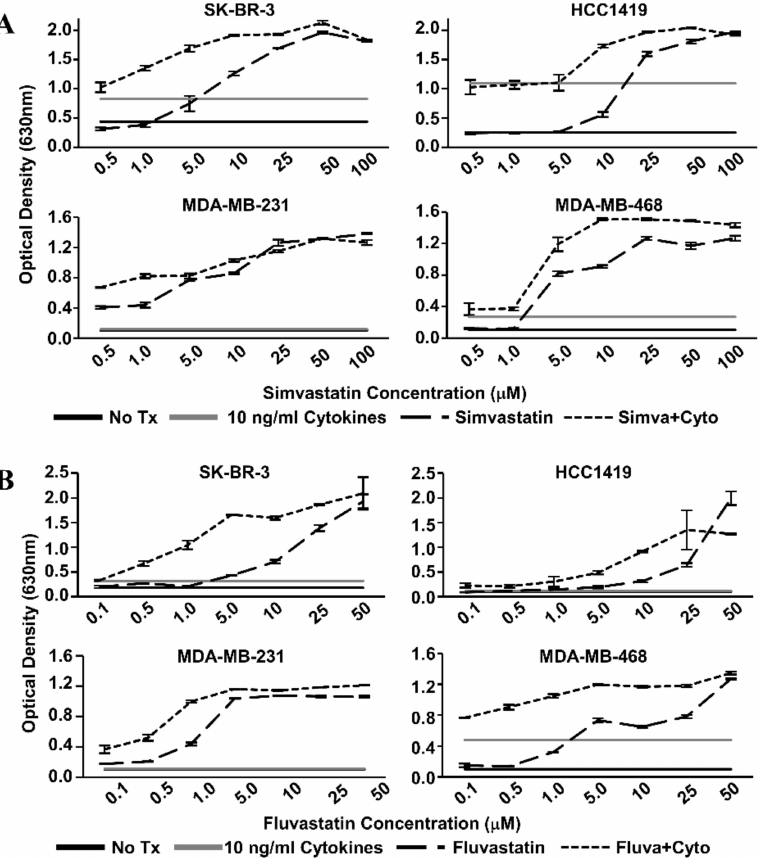
Figure 1. Statin dose–response curves via Alamar Blue dye reduction assay. Human breast cancer cell lines(SK-BR-3, HCC1419, MDA-MB-231, andMDA-MB-468)weretreatedwithincreasingconcentrations of ( A ) Simvastatin or ( B ) Fluvastatin in the presence (short dash) or absence (long dash) of recombinant Th1 cytokines (Tumor Necrosis Factor-alpha, TNF- α and Interferon-gamma, IFN- γ , 10 ng / mL each) for 72 h. Alamar Blue dye was added and, following color change, the optical density of the dye in the culture supernatants was determined. Optical Density (OD) values of untreated controls (black) and cytokine only treatment (gray) are represented as horizontal